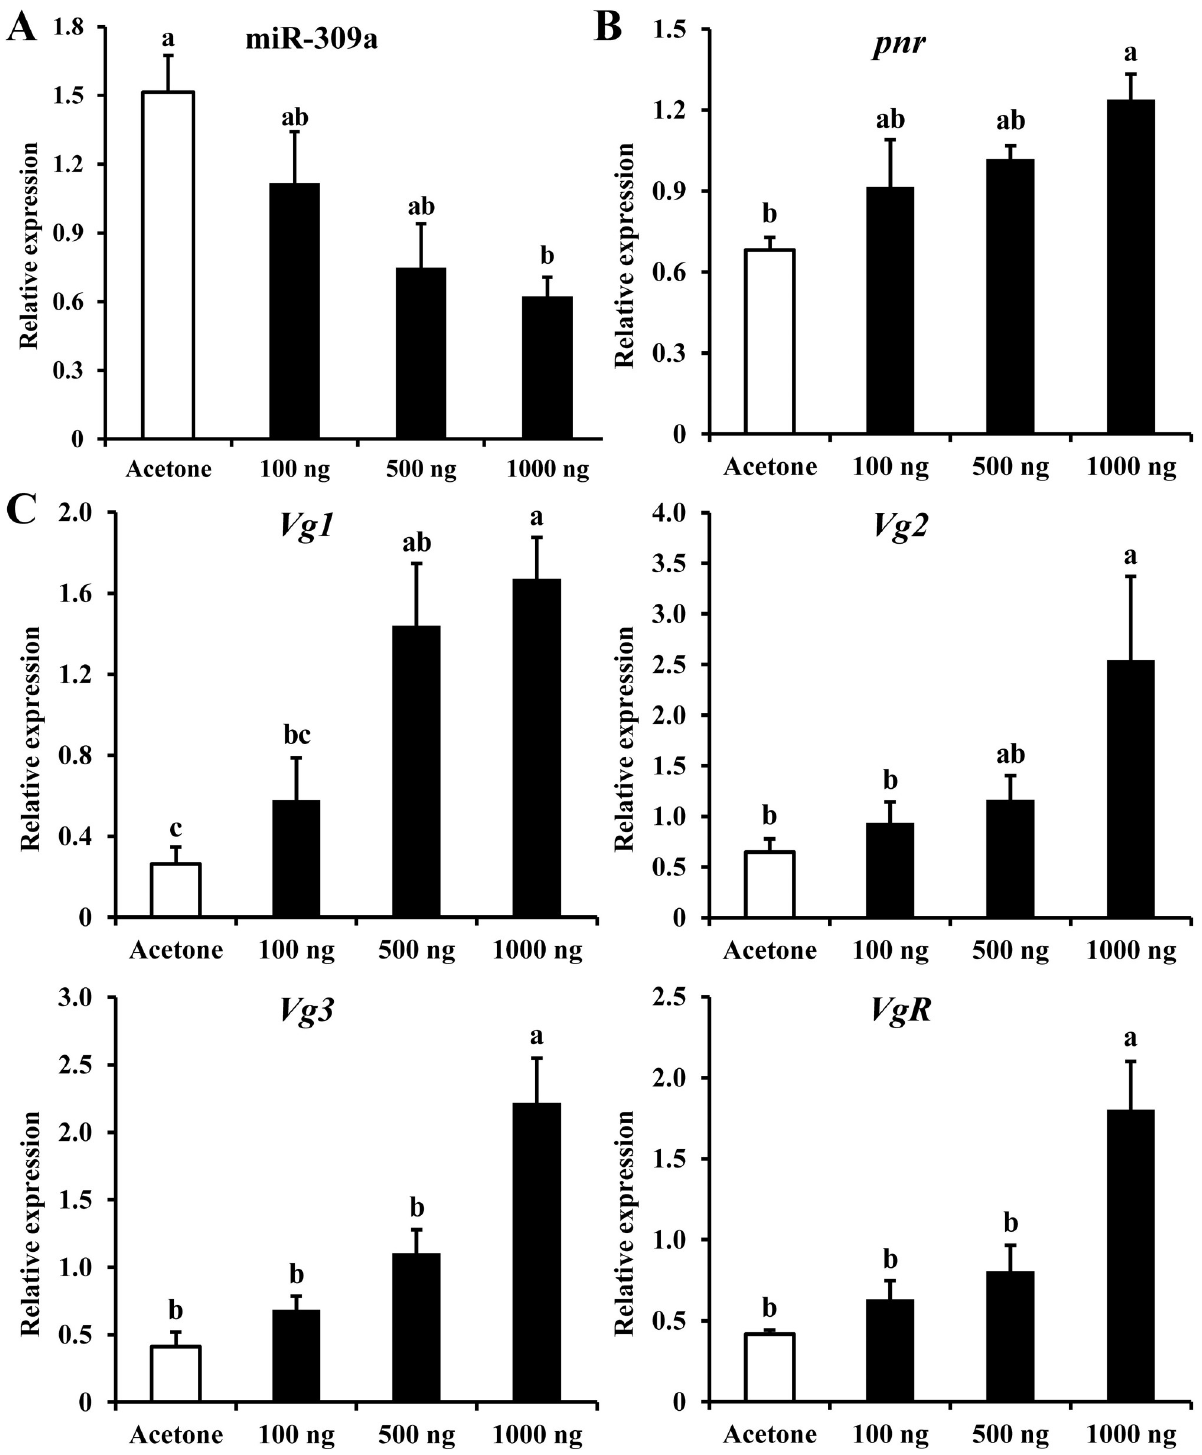
Fig 7. Effects of methoprene treatment on the expression of miR-309a regulatory pathway genes in B . dorsalis female adults. (A) Relative expression of miR-309a. (B) Relative expression of pnr . (C) Relative expression of Vg -related genes. Data are means ± SE (error bars) of four biological replications. U6 or a-tubulin and rps3 were reference genes used to normalize the expression of miRNA or mRNA. Different letters above the bars indicate significant differences of the miRNA or mRNA at different doses of methoprene (Tukey’s HSD, ANOVA, P < 0.05).